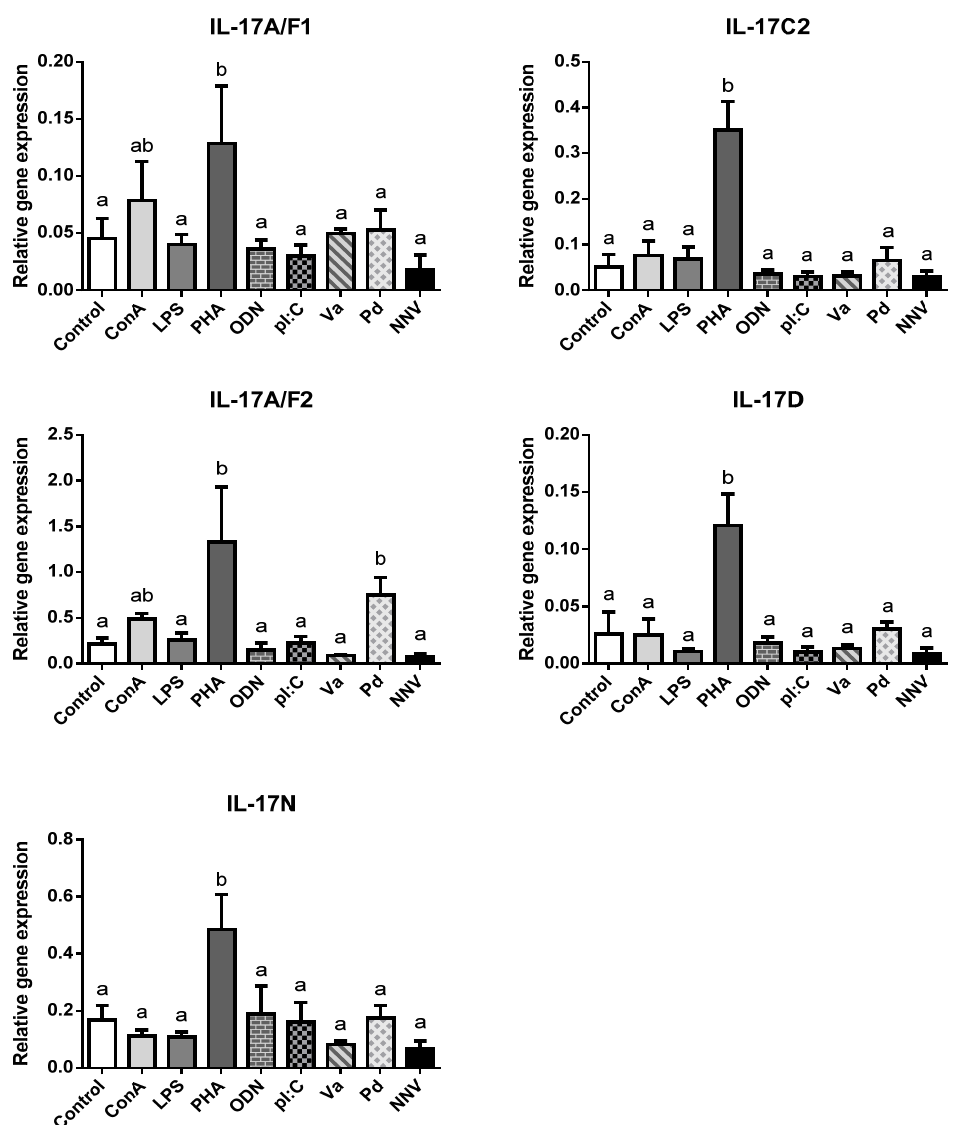
Figure 3. Transcription of European sea bass IL-17 ligands is induced in head-kidney leucocytes by T cell mitogens . The relative gene expression of IL-17 ligands in the European sea bass head-kidney leucocytes incubated for 4 h with culture medium (Control), 5 µ g / mL concanavalin A (ConA), 5 µ g / mL lipopolysaccharide (LPS), 10 µ g / mL phytohemagglutinin (PHA), 50 µ g / mL synthetic unmethylated cytosine-phosphodiester-guanosine oligodeoxynucleotide 1668 (ODN), 25 µ g / mL PolyI:C (pI:C), 10 8 heat-killed Vibrio anguillarum (Va) or Photobacterium damselae (Pd) bacteria / mL, and 10 6 TCID 50 nodavirus (NNV) / mL. The data are presented as the mean ( n = 5) ± SEM relative to the expression of the endogenous controls. Di ff erent letters indicate di ff erences in gene expression (ANOVA, p < 0.05).